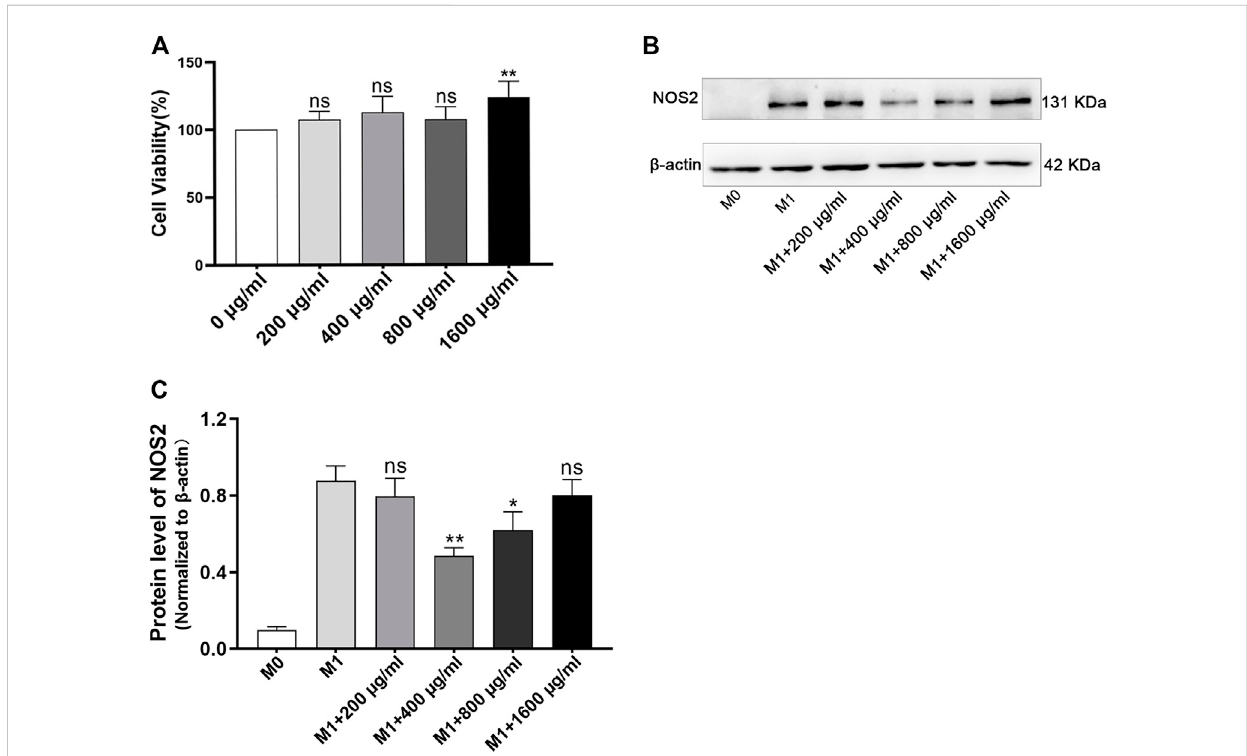
FIGURE 3 The effect of LBP on cell viability in RAW264.7 cells and the selection of optimal concentration of LBP for macrophage polarization. (A) The RAW264.7cellswereculturedwithdifferentdosagesofLBPfor24 h,andthecellviabilitywastested.** p < 0.01vs.0 μ g/mLgroup(100%cellviability).Ns, no signi fi cance. (B) The proteinlevel of NOS2 was detected inRAW264.7 treated with LBPand LPS/IFN- γ for 24 h viaWesternblot. (C) The quanti fi cation of NOS2 in Figure 3B in each group. * p < 0.05, ** p < 0.01 vs. the M1 group. Ns, no signi fi